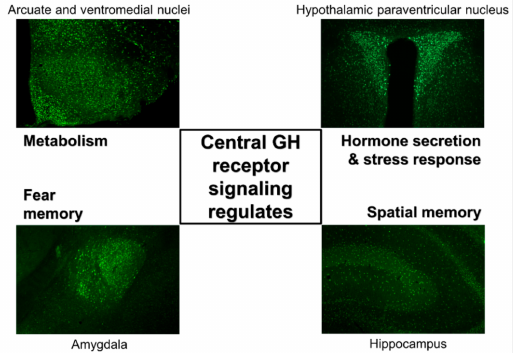
Figure 2. GH-responsive neurons are found in several brain structures, and GH receptor signaling regulates different neurological aspects. Coronal photomicrographs of different parts of the mouse brain showing immunoreactivity against the phosphorylation of the signal transducer and activator of transcription 5 after an acute GH injection. Previous studies indicated that GH receptor signaling in different brain areas regulates distinct physiological parameters. Although GH-responsive neurons are abundantly found in the paraventricular nucleus of the hypothalamus, the exact role played by GH in these cells is still